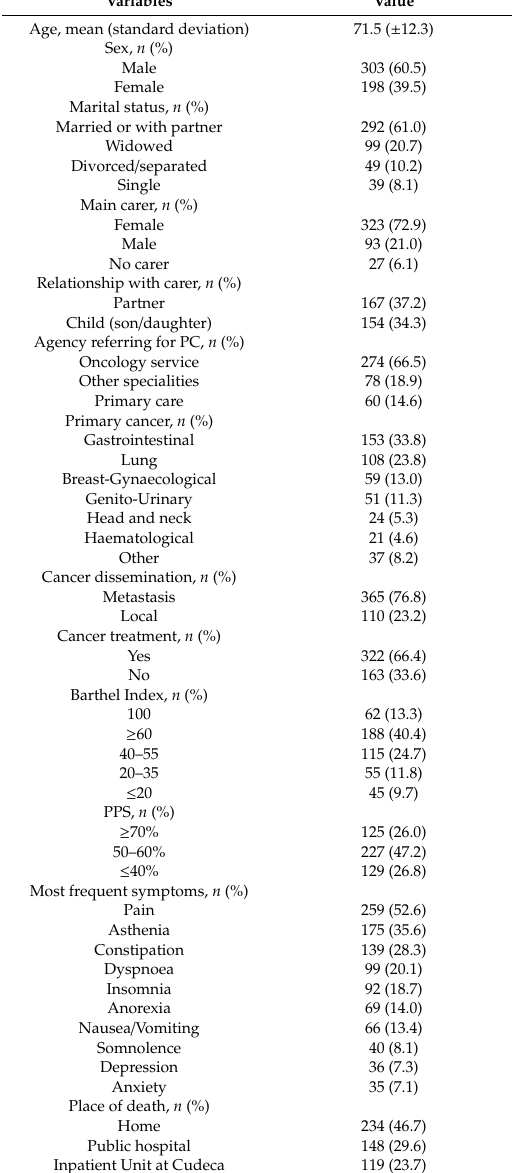
Table 1. Characteristics of the study population ( N =